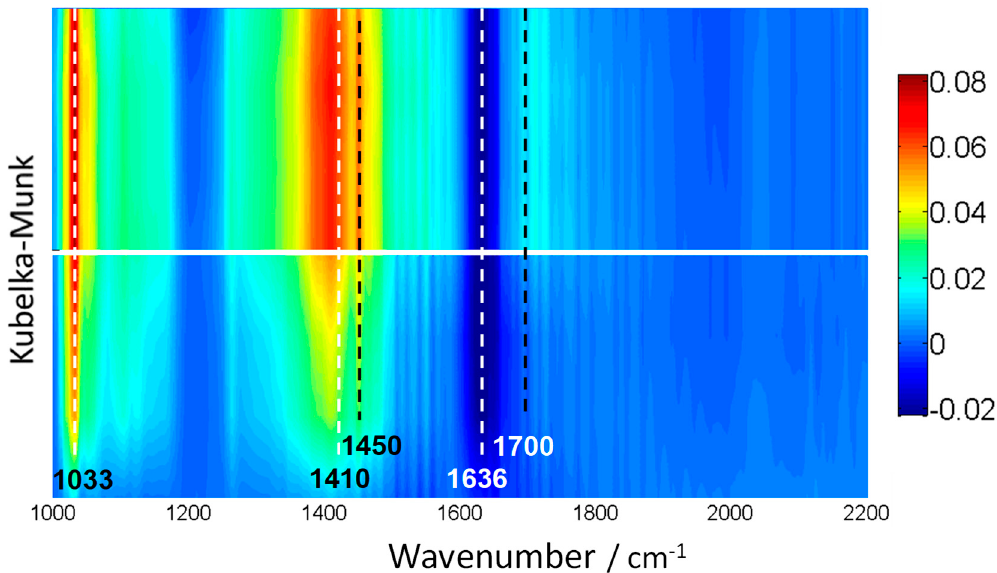
Figure 5. Difference infrared spectra of the T sample using a 70/30 methanol/water reaction mixture under dark ( bottom panel ) and illumination ( upper panel ).